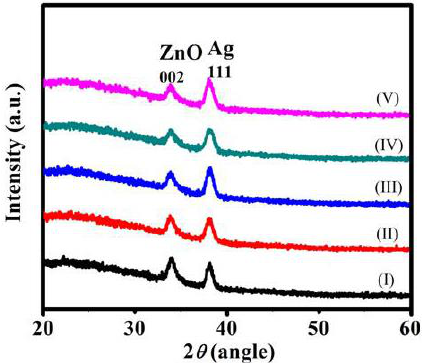
Figure 2. X-ray diffraction (XRD) patterns of ZnO/Ag/ZnO films obtained at different f(O 2 ): ( I ) 0; ( II ) 1.0%; ( III ) 2.0%; ( IV ) 3.0% and ( V ) 4.0%.